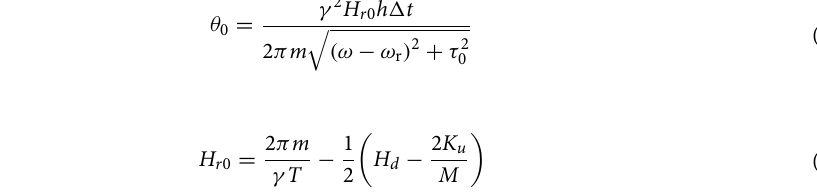
(Fig. 1e): (I) at the center of the disk (red circles); (II) at a distance L = 15 µm apart from the edge of the disk along the direction of the magnetic field, i.e. along the x axis (black circles); (III) at a distance L = 7 µm apart from the edge of the disk along the x axis (green circles), and (IV) at a distance L = 7 µm apart from the edge of the disk in a direction perpendicular to the magnetic field, i.e. along the y axis (blue circles). For the illumination at the microdisk center (I) the amplitude dependence θ 0 ( H ) has a single peak at H r 1 = 2.98 kOe, while for the other positions there are additional peaks in the θ 0 ( H ) dependence. The main peak at around 2.98 kOe is due to the synchronization of the magnetization oscillations and pump pulses, as we discussed earlier. However, the most important feature of the θ 0 ( H ) dependence is the second peak (see Fig. 1e, black and green circles). Its position shifts to higher fields for the light spot moving closer to the microdisk edge. For the L = 15 µm separation from the edges (point (II)) the peak appears at the magnetic field of 3.06 kOe, while for L = 7 µm (point (III)—at 3.14 kOe. Apart from that, for the point (II) there is also a minor peak at 3.16 kOe and for the point (III) there is a feature at 3.04 kOe, that broadens and shifts the main resonance to higher magnetic